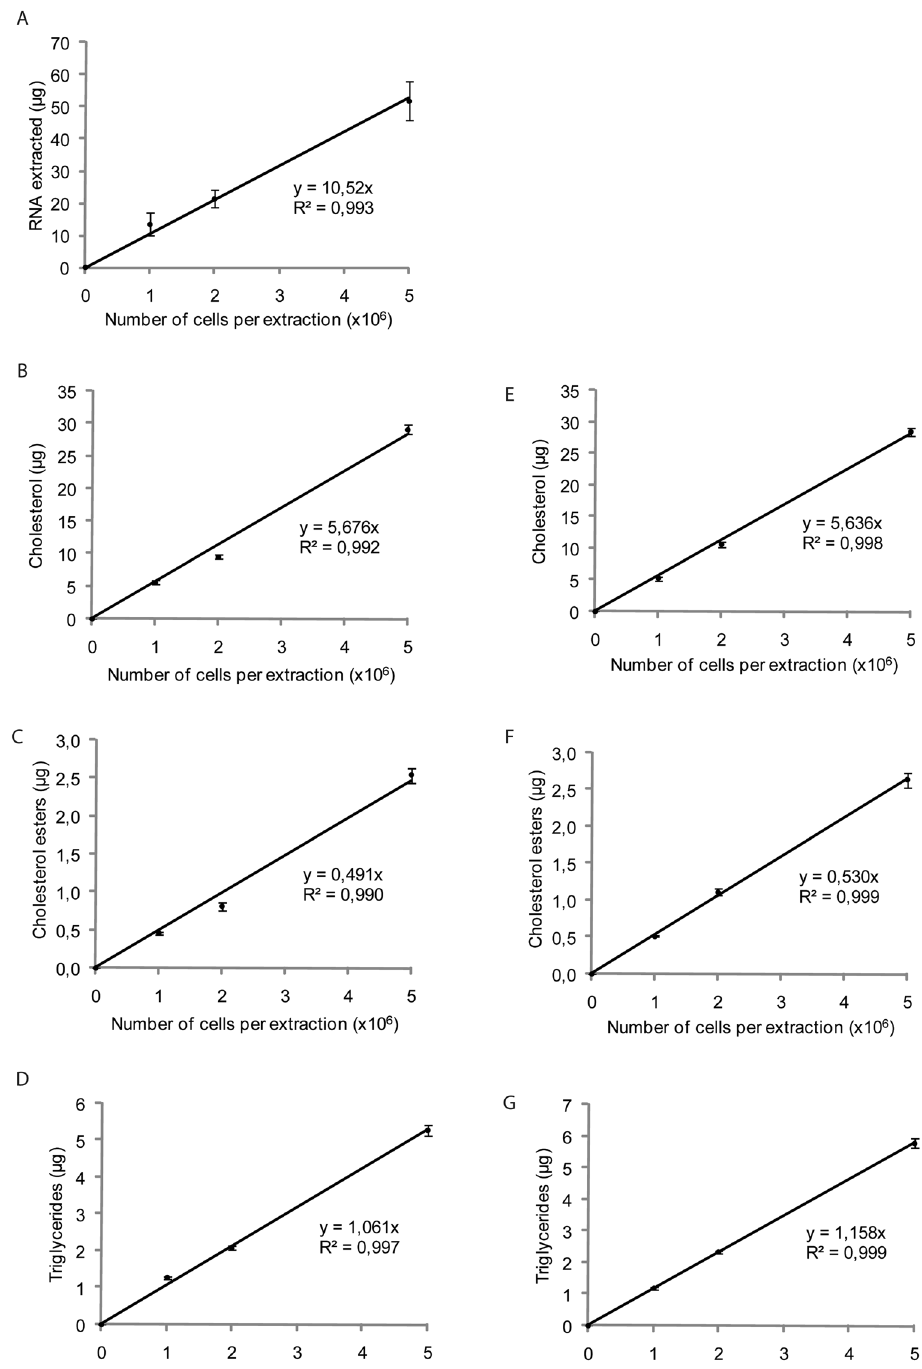
Figure 3. Trizol can be used to extract total lipids from hepatocytes. ( A ) Commercially available Trizol was used to extract mRNA and ( B ) cholesterol, ( C ) cholesterol esters, and ( D ) triglycerides from 1 to 5 × 10 6 JWZ cells. ( E ) Bligh & Dyer was also used for cholesterol, ( F ) cholesterol ester, and ( G ) triglyceride extraction from 1 to 5 × 10 6 JWZ cells. RNAs were analyzed by qPCR and lipids by gas chromatography. Data are presented as means ± s.e.m. (n = 4 samples per